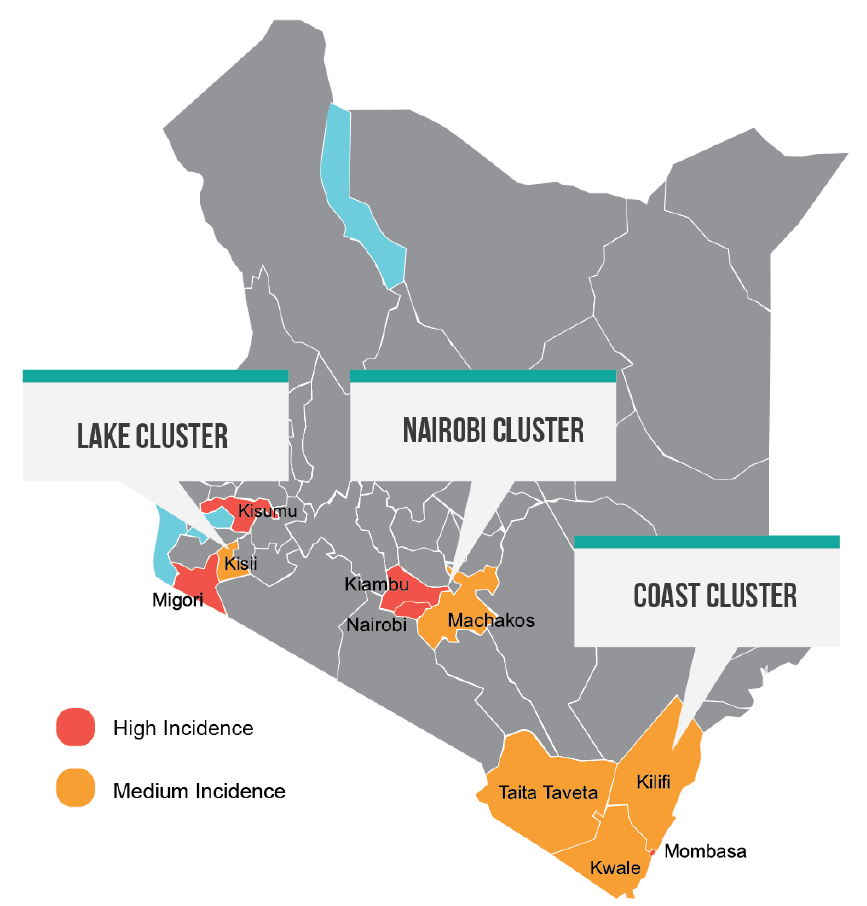
Figure 1. Geographic coverage of the Jilinde project based on HIV